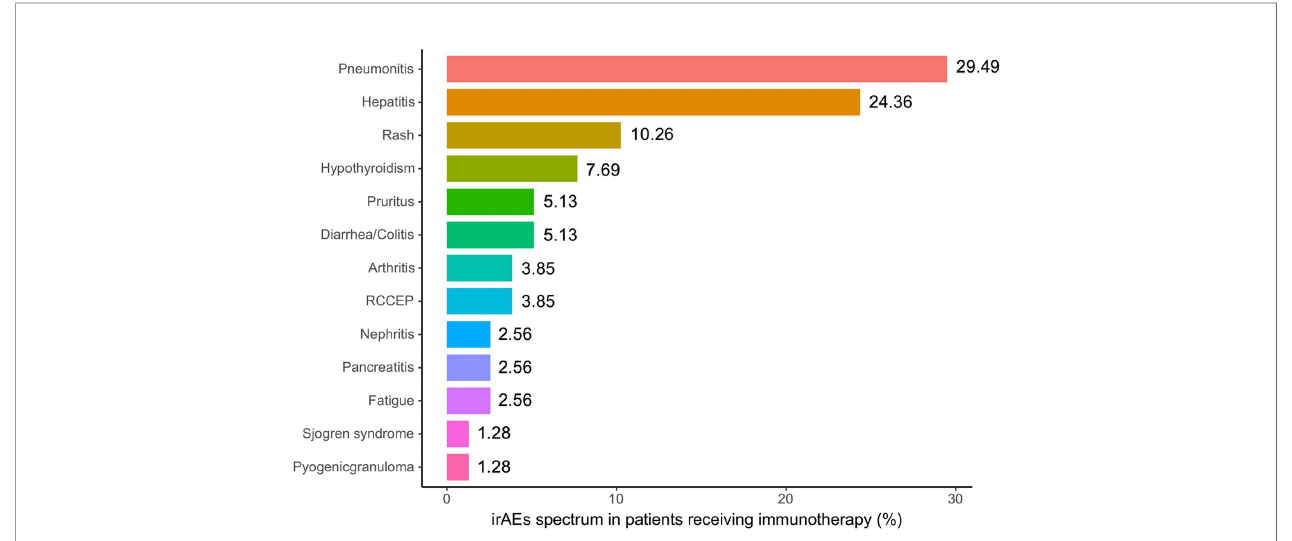
FIGURE 1 | IrAE spectrum in patients receiving immunotherapy. Rates of individual diseases in all included irAEs (n = 78). irAEs, immune-related adverse events; RCCEP, reactive cutaneous capillary endothelial